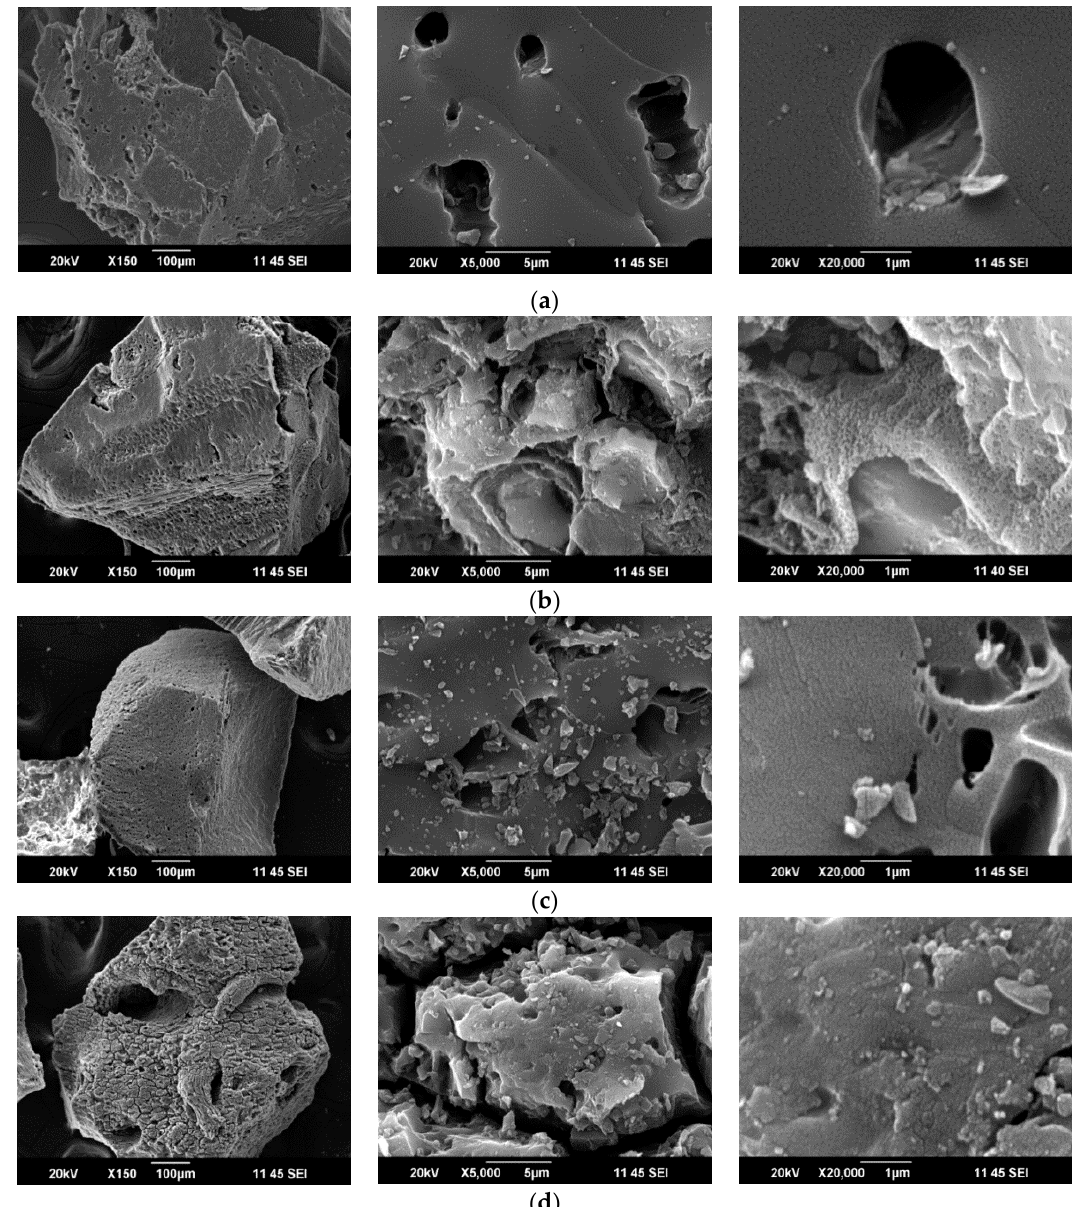
Figure 1. SEM micrograph at different magnifications for ( a ) GAC; ( b ) GACoxN; ( c ) GACoxP; and ( d ) GACoxCl.